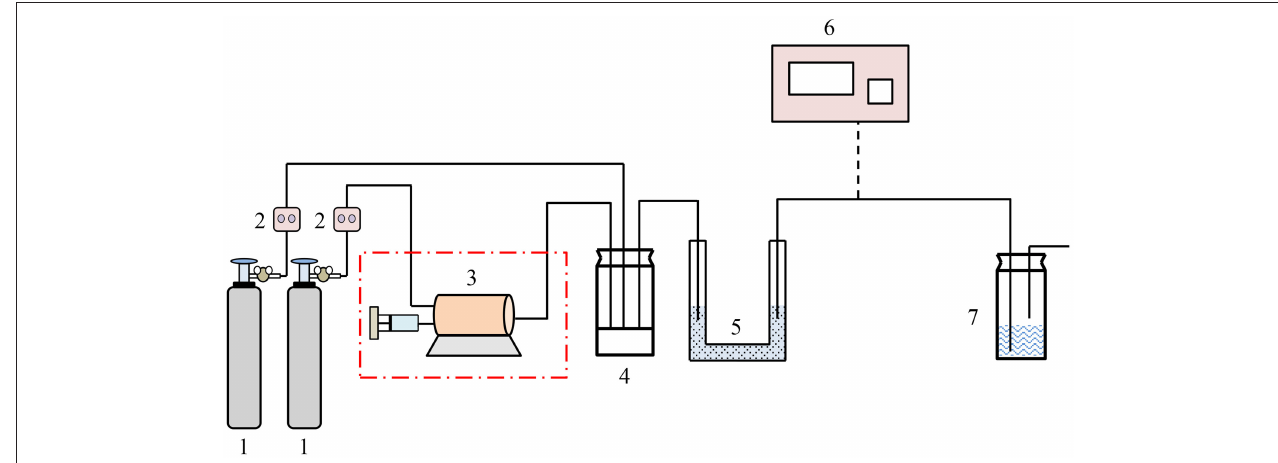
FIGURE 4 | VOCs adsorption experimental apparatus.